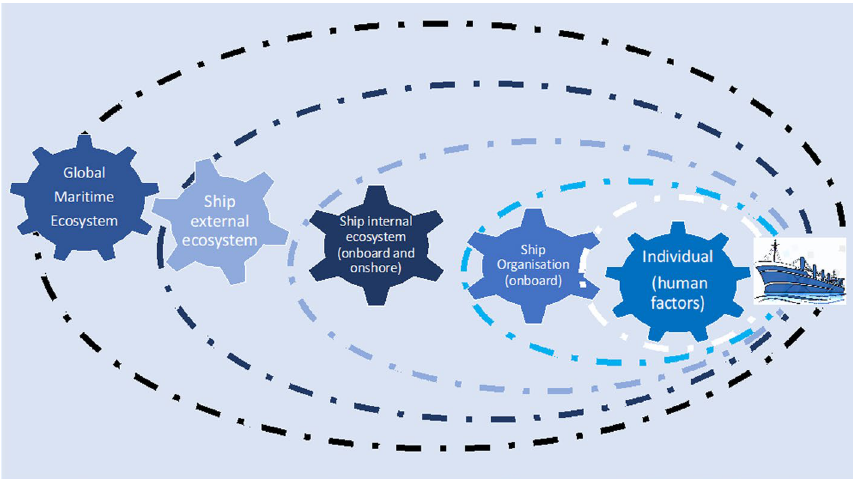
Fig. 7 Accident maritime ecosystem (AME) framework. Source: